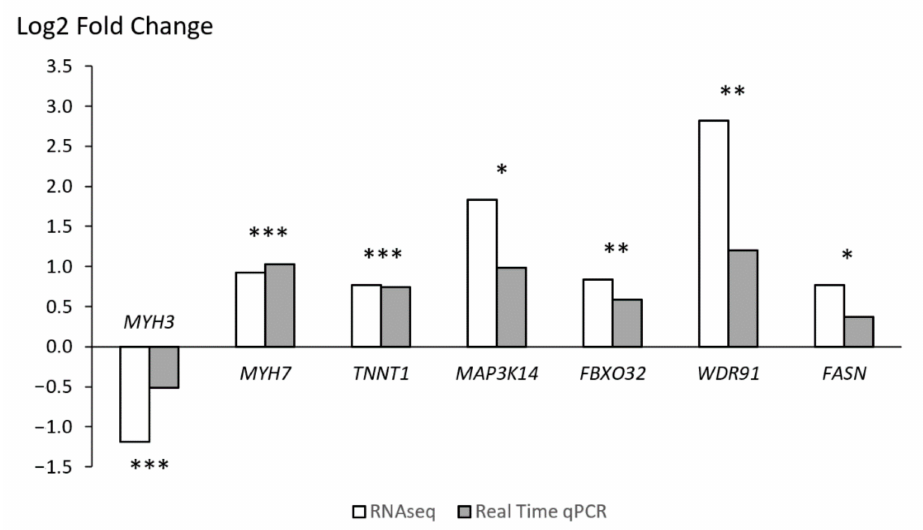
Figure 1. Gene expression comparison of MYH3 (Myosin heavy chain 3), MYH7 (Myosin heavy chain 7), TNNT1 (Troponin T1), MAP3K14 (Mitogen-activated protein kinase kinase kinase 14), FBXO32 (F-Box Protein 32), WDR91 (WD Repeat Domain 91) and FASN (fatty acid synthase) with RNA-seq and Real Time qPCR of the Longissimus lumborum of Alentejano (AL) and B í saro (BI) pigs ( n = 10). Positive values indicate overexpression in AL and negative values overexpression in BI. Pearson correlation values fluctuated between 0.93 ( MYH3 ) and 0.58 ( FASN ). Significance of the correlation: *** p < 0.001, ** p < 0.01, * p <